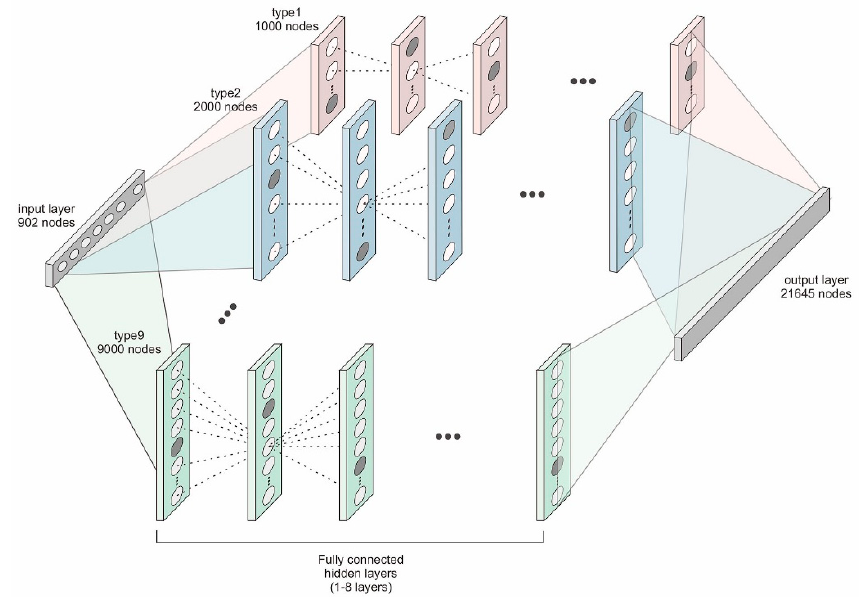
Figure 2. The architecture of Deep-Gene Promoter Methylation (D-GPM). It is comprised of one input layer, one or multiple hidden layers, and one output layer. All the hidden layers have the same number of hidden units.